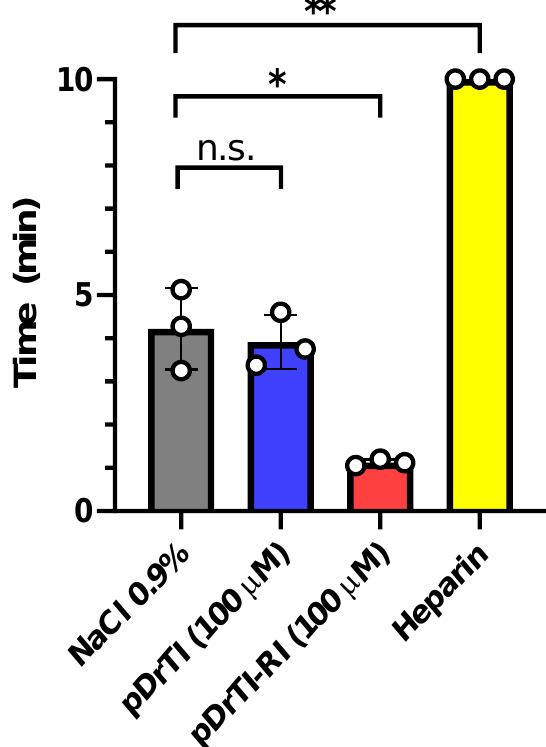
Figure 7. Tail vein bleeding time—Mice were treated with pDrTI, pDrTI-RI, or heparin. After 10 min, a 2 mm longitudinal incision was made at the end of the mouse’s tail. The sectioned tail was immersed in a saline solution (NaCl 0.9%) at 37 ◦ C and the time required for bleeding cessation was recorded for up to 10 min. N = 3 animals. Statistical analysis was made using t -test with Welch’s correction using GraphPad Prism 8. n.s.: non-significant; * p < 0.05; ** p < 0.01.